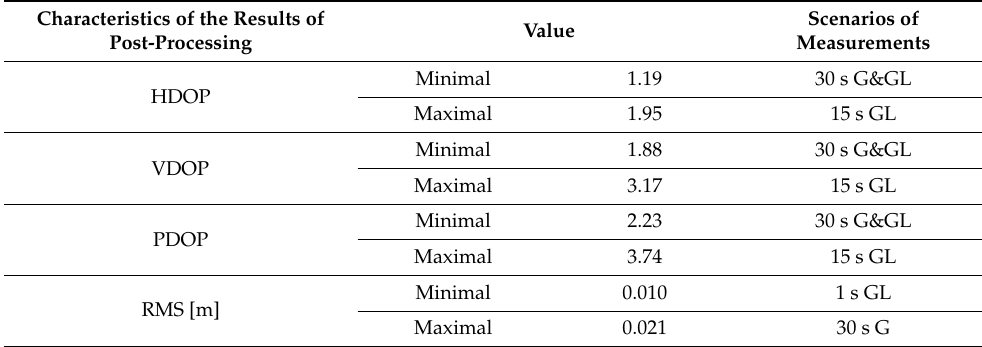
Table 1. The extreme value of DOP and RMS for different scenarios of rapid static